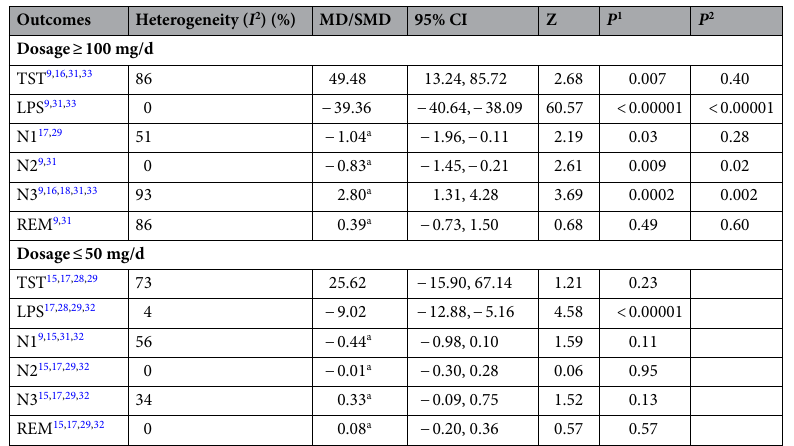
Table 4. Subgroups based on the different dosages of trazodone. CI confidence interval, LPS latency to onset of persistent sleep, MD mean differences, N1 non-rapid eye movement stage 1, N2 non-rapid eye movement stage 2, N3 non-rapid eye movement stage 3, P 1 variation within the group, P 2 differences between subgroups, REM rapid eye movement, SMD standardized mean differences, TST total sleep time. a SMD.